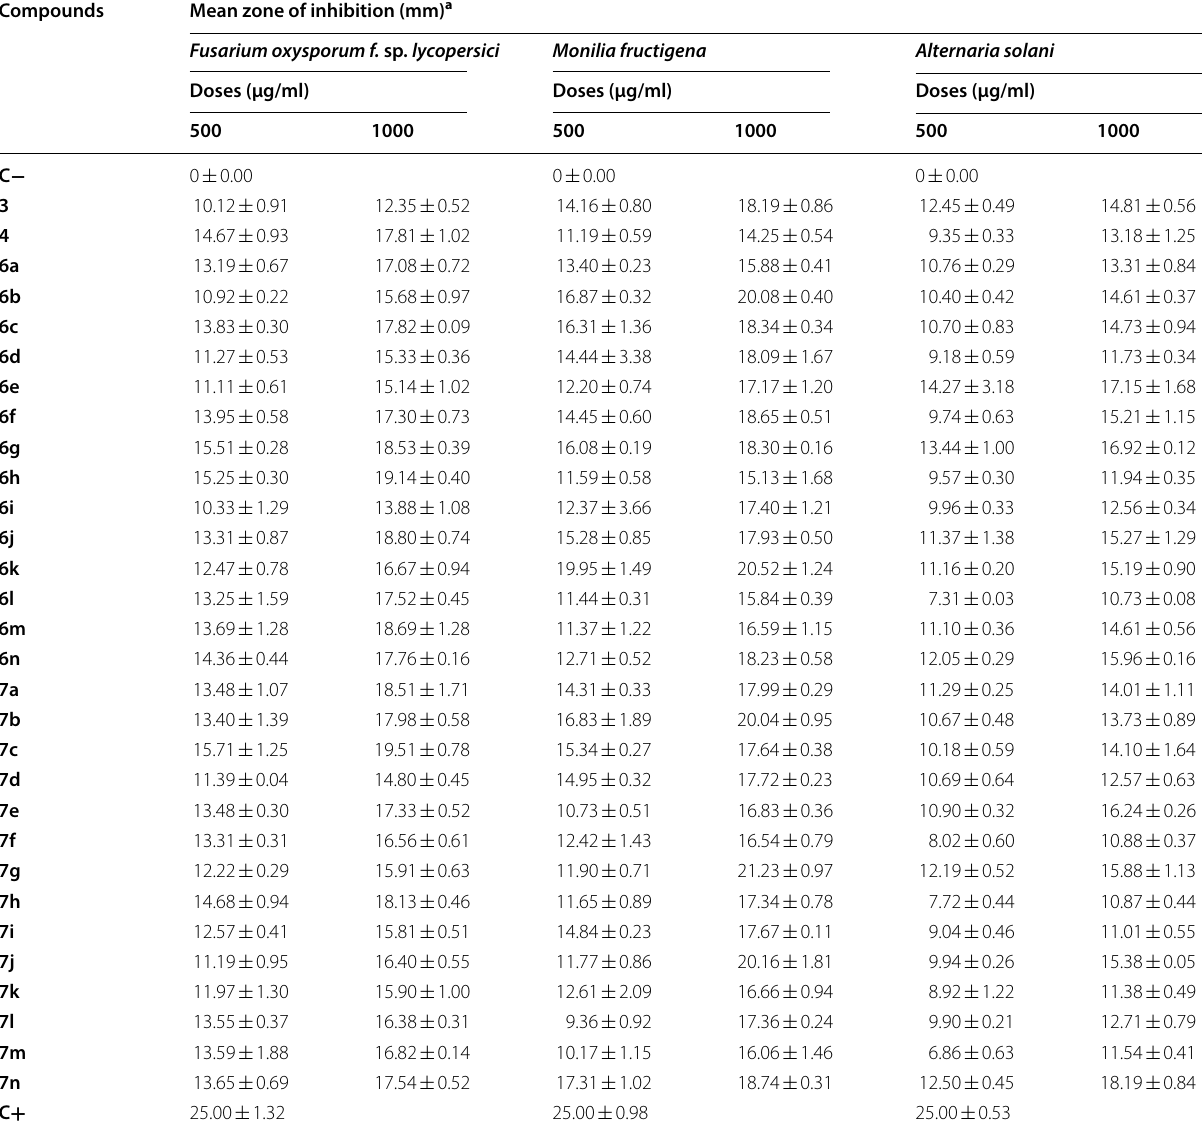
Table 1 Inhibition zones of compounds against plant pathogens Compounds Mean zone of inhibition (mm)